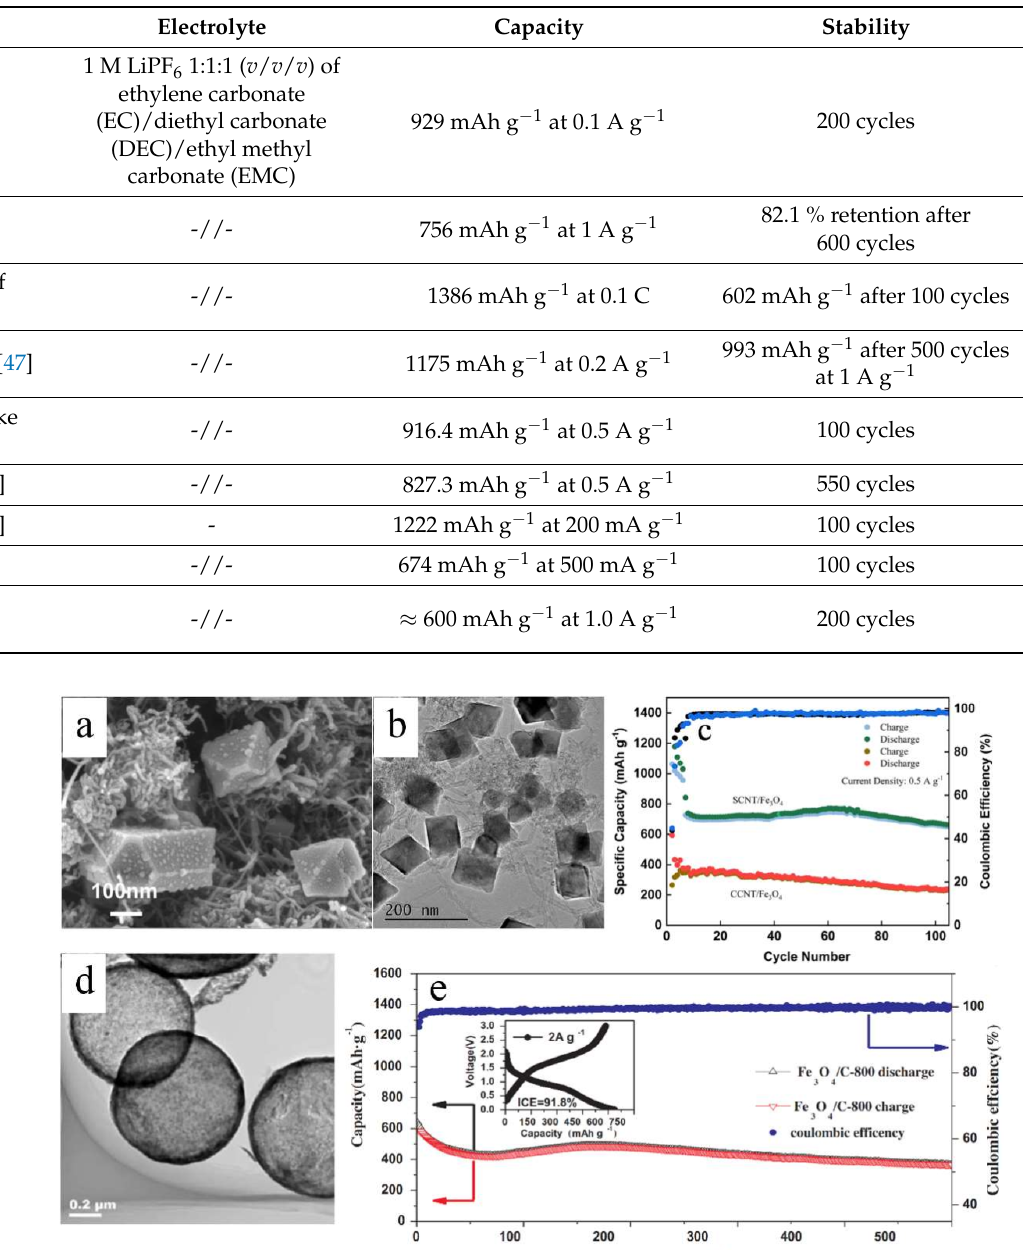
Table 1. Synoptic comparison of the electrochemical performances obtained in Li-ion cells for some types of hybrid nanostructures containing iron oxides and carbonaceous materials. These active nanomaterials were investigated as potential anodes for LIBs and typically cycled between 0.01 and 3.0 V vs. Li + /Li.